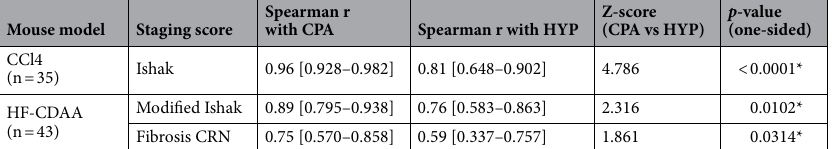
Table 2. Comparison of Spearman correlation rates performed with MorphoQuant CPA quantitative analysis and hydroxyproline (HYP) assay using the one-sided Fisher’s Z transformation, considering histopathological scoring as the